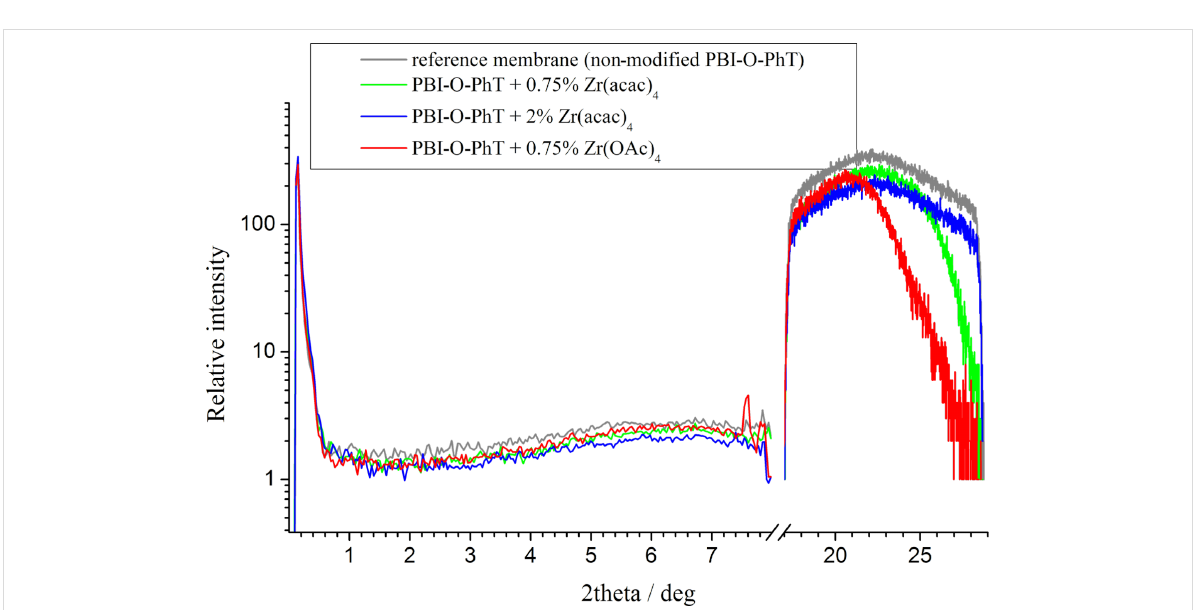
Figure 3: Small angle X-ray scattering results for the different types of composites and the reference membrane.